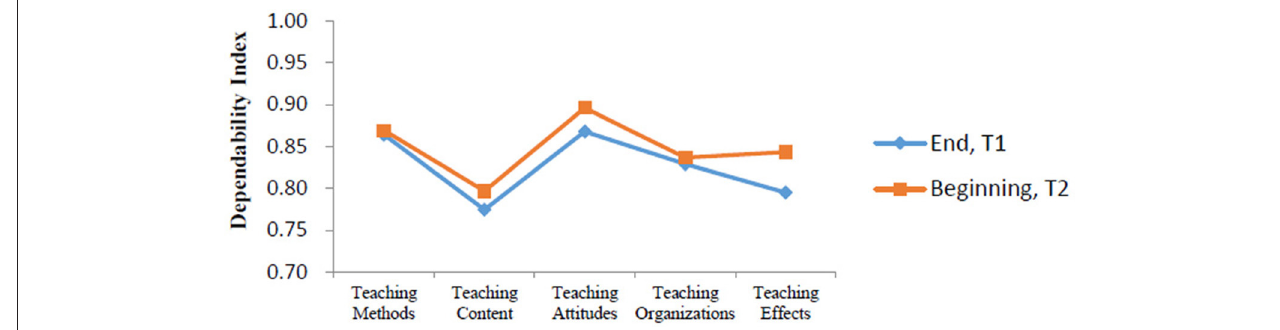
FIGURE 1 | Dependability indexes for two different evaluation time points.